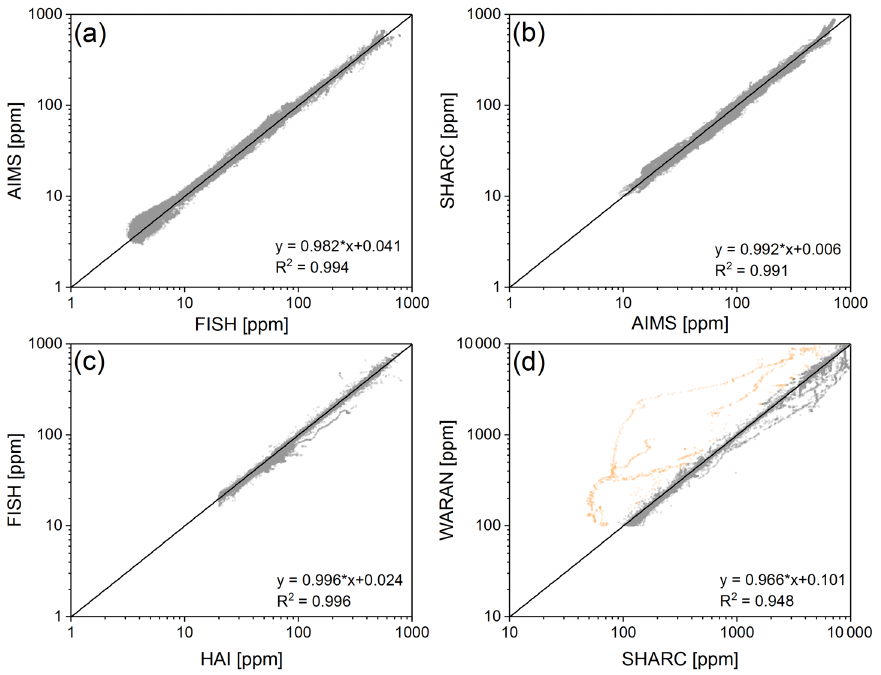
Figure 3. Scatterplots of data from the five in situ water vapor instruments on HALO during ML-CIRRUS. (a) Clear-sky measurements of AIMS and FISH covering the stratosphere and upper troposphere, (b) AIMS and SHARC measuring gas phase H 2 O. This plot thus includes in-cloud gas phase H 2 O data. (c) HAI vs. FISH for clear-sky upper-tropospheric mixing ratios. (d) WARAN vs. SHARC data extending up to 10000ppm with a lower cutoff of the WARAN at 100ppm. The strong wet bias of the WARAN that occasionally occurs during the first ascent of the plane is marked orange. These data points are left out for the further